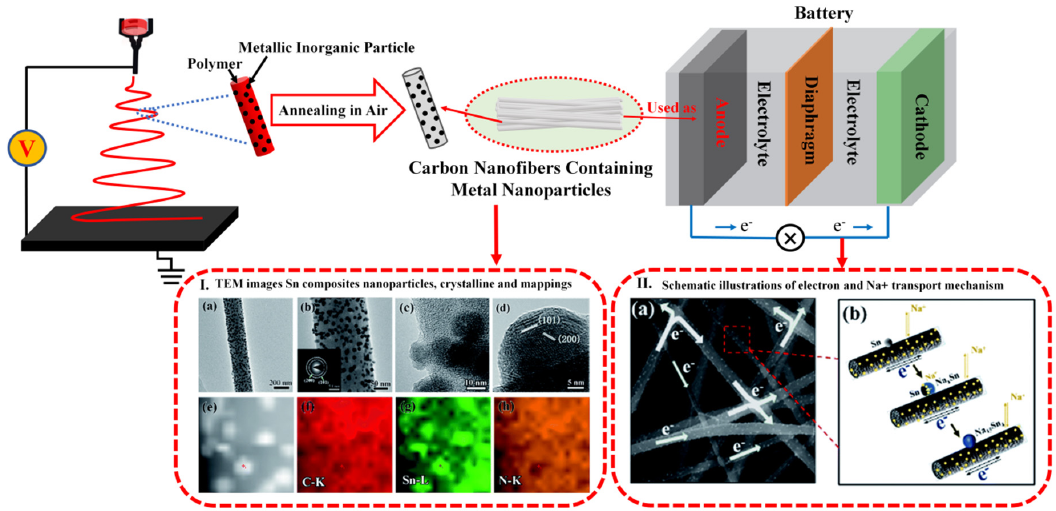
Figure 5. Polymer solutions can be mixed with inorganic metal nanoparticles and electrospun into ecofriendly composite nanofibers as an anode material in a battery after an annealing process. Reproduced with permission from [140]; copyright (2017) Royal Society of Chemistry.